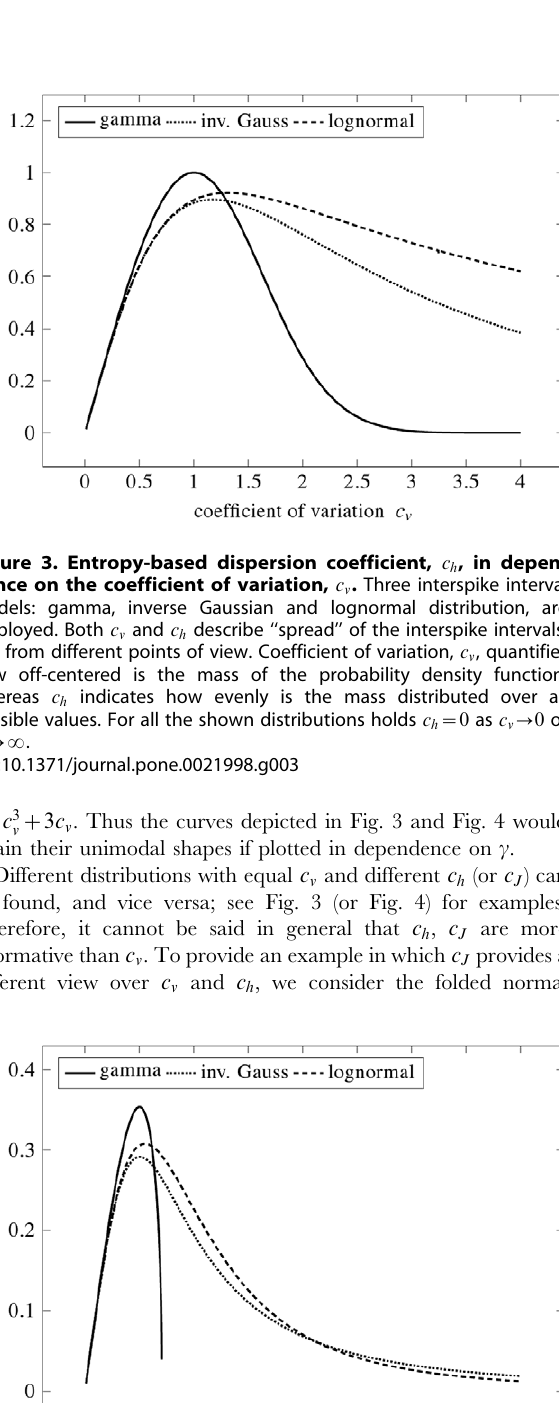
Figure 4. Fisher information-based dispersion coefficient, c J , as a function of the coefficient of variation, c v , for the same distributions as in Fig. 3. The coefficient c J grows as the average of squared derivative of the probability density function (see Eq. (7)) becomes smaller, that means as the distribution of the interspike intervals becomes more smooth. This confirms that ‘‘smoothness’’ and ‘‘evenness’’ of the distribution (compare with Fig. 3) are different notions, although there are qualitative similarities: c J ~ 0 for c v ? 0 for all shown distributions, and c J ~ 0 as c v ? ? for both lognormal and inverse Gaussian distributions. Note, that dispersion coefficient c J for the gamma distribution can be calculated only for c v v 1 = ffiffiffi 2